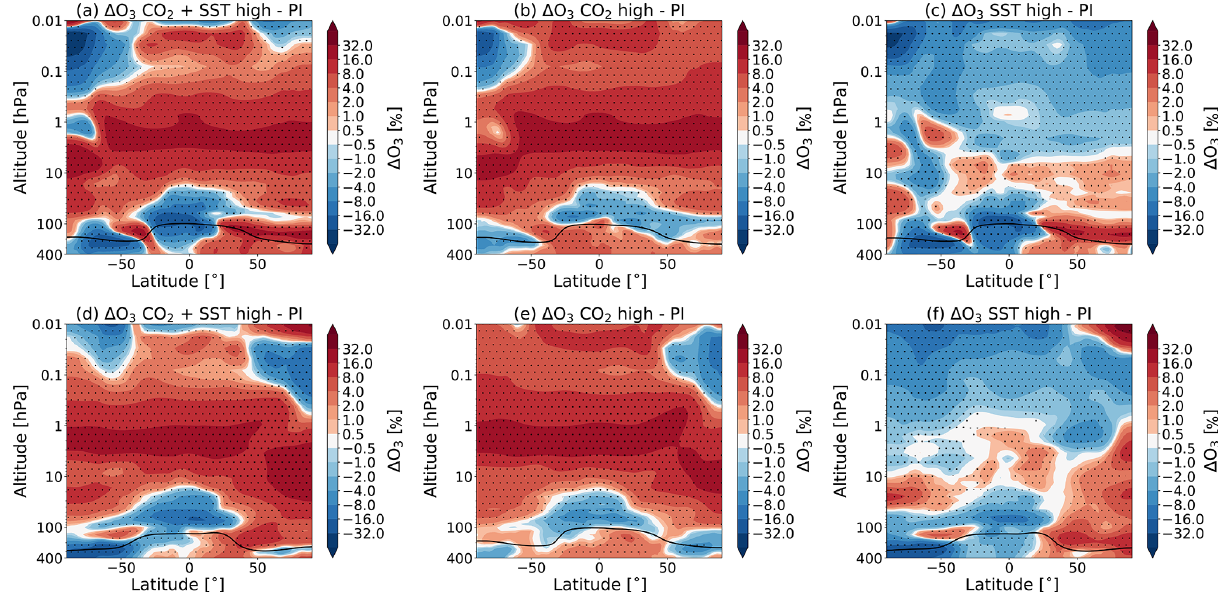
Figure 3. The percentage change in the zonal and monthly mean ozone concentration for July (a–c) and January (d–f) due to (a, d) the combined effect of the CO 2 increase and SST changes (experiment S3–C1), (b, e) the doubling of the atmospheric CO 2 concentration (experiment S1–C1) and the (c, f) SSTs (experiment S2–C1) as simulated by WACCM. The dotted regions indicate the regions where the data reach a confidence level of 95%. The tropopause height is indicated as in Fig.